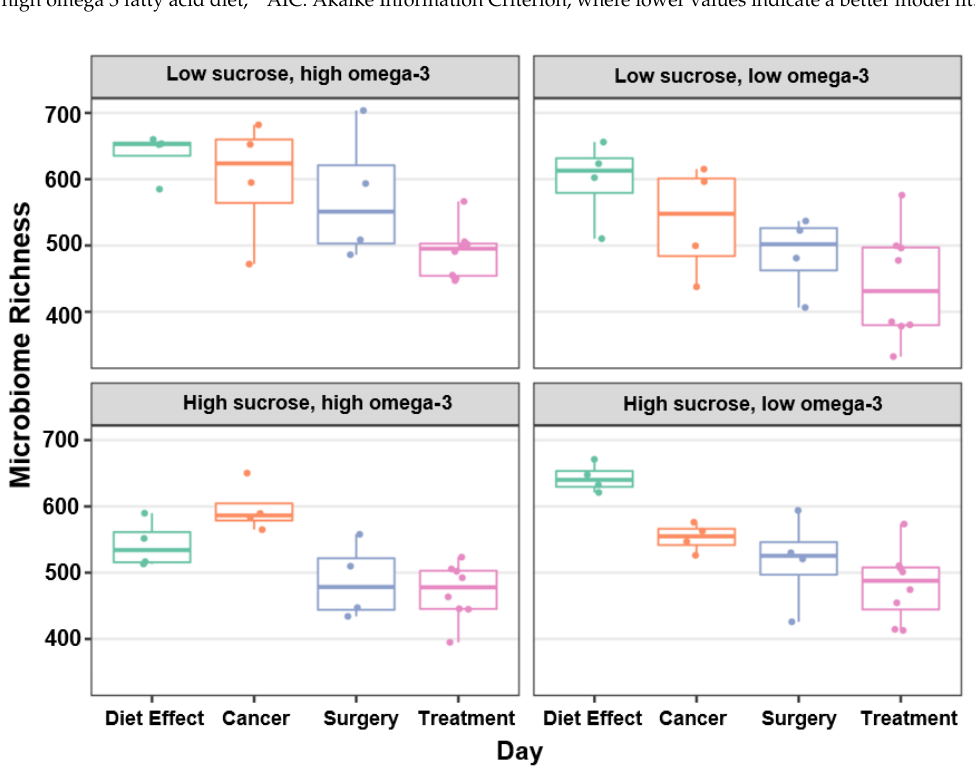
Figure 2. Estimated richness over progression of cancer and treatment, by diet. Microbiome popu- lation richness significantly decreased over time.